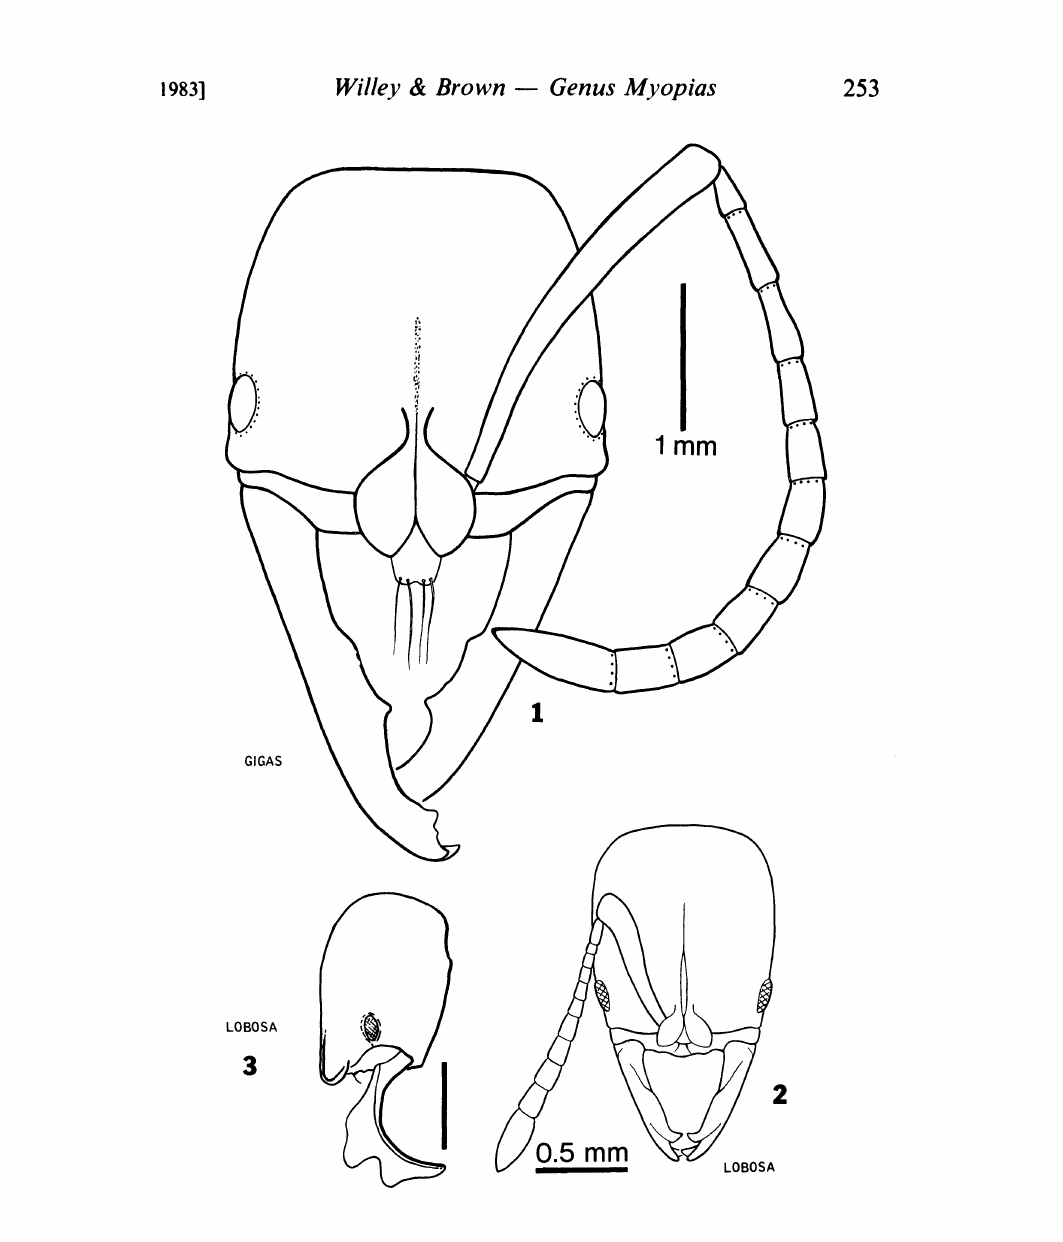
Figs. 1-3, Myopias spp., heads of workers, sculpture and pilosity omitted. Fig. 1, M. gigas holotype in full-face view. Fig. 2, M. Iobosa, paratype in full-face view. Fig. 3, M. iobosa, another paratype in side view. Scale bars for Figs. 2 and 3 are 0.5